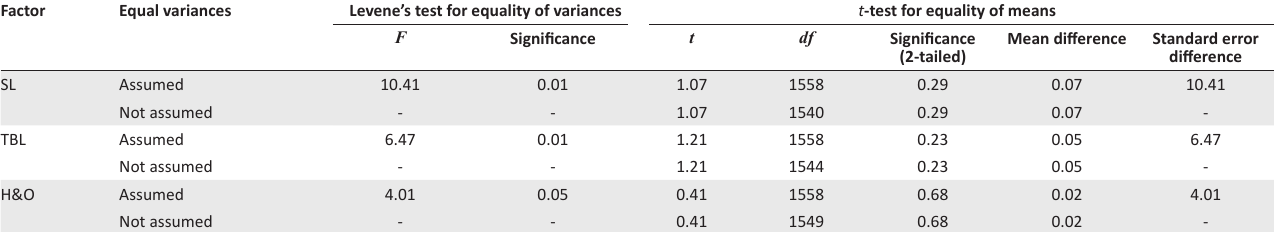
TABLE 3: t -test (between group differences) with sector as grouping variable and servant leadership, team-based learning and hope and optimism. Factor Equal variances Levene’s test for equality of variances